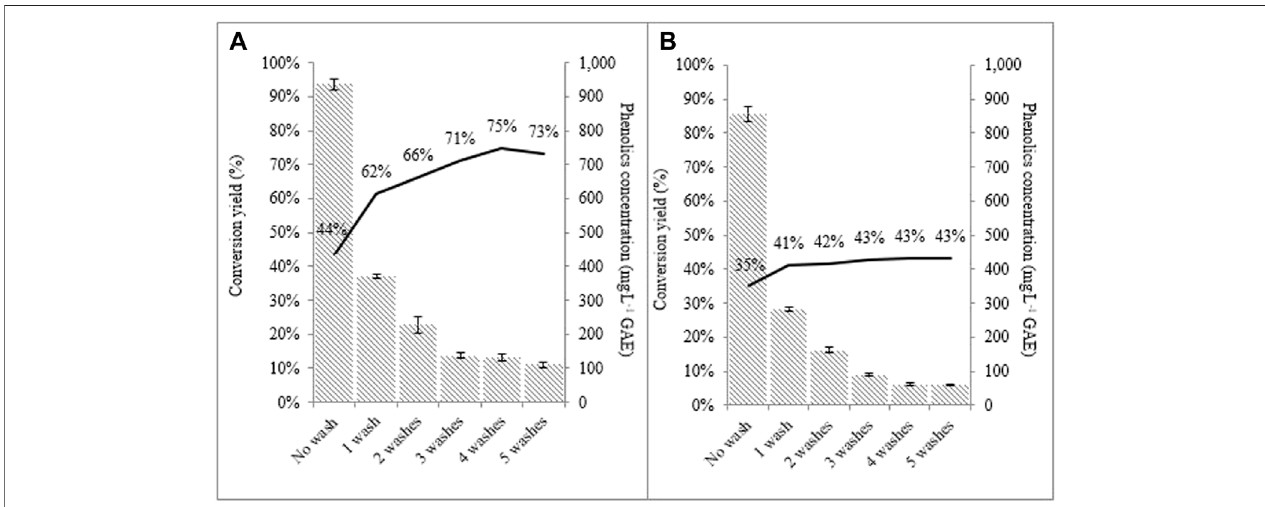
FIGURE 4 | Concentration of phenolic compounds (bars) and cellulose conversion yield (lines) in enzymatic hydrolysis (17.5 mg protein × g − 1 glucan; 10% total solids loading, 96 h) related to sequential room temperature washes. (A) ozone-pretreated sugarcane bagasse; (B) LHW-pretreated sugarcane bagasse.